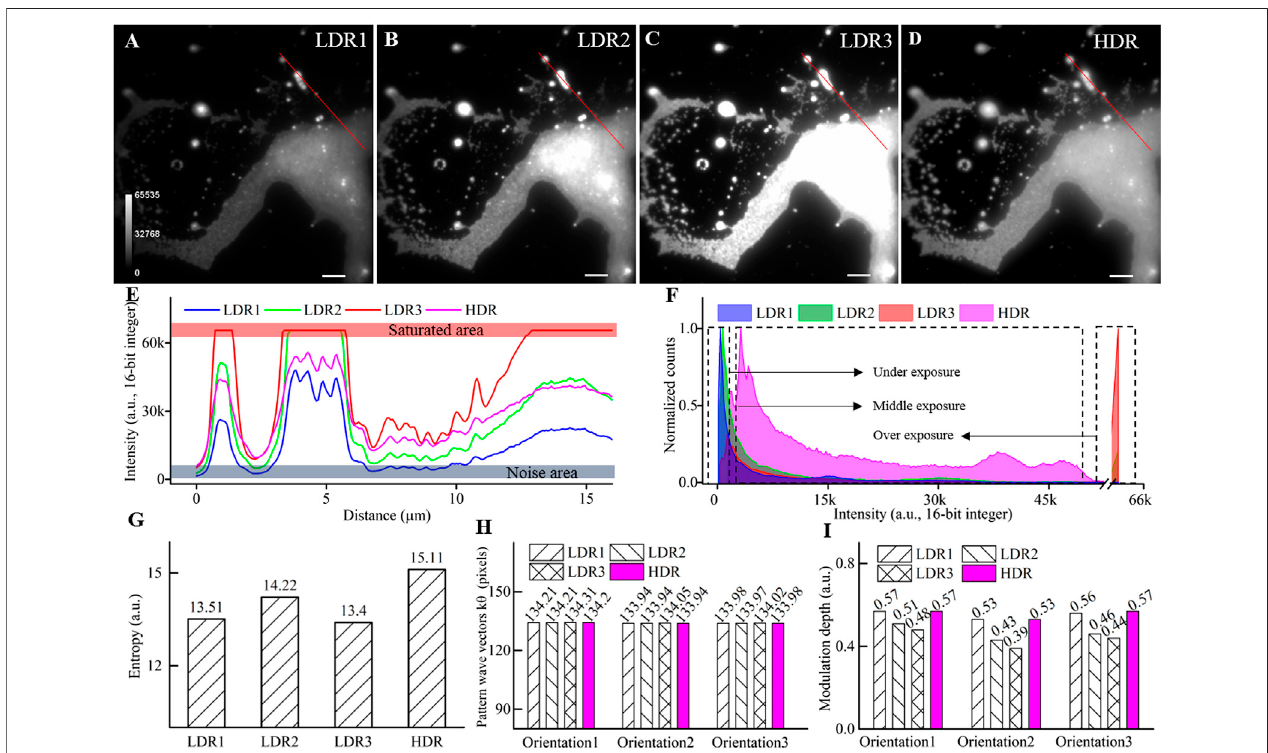
FIGURE 2 | Performance of the HDR fusing to widen the dynamic range. (A – C) LDR images of clustered fl uorescent beads acquired with different excitation intensitiescorrespondingtounder,middle,andoverexposure. (D) HDRimagebyfusingtheabovethreeLDRimages. (E) Intensitypro fi lesalongtheredlinesin (A – D) . (F) The normalized histogram. (G) The entropy of the LDR and the HDR image. (H) Period of illumination pattern wave vector ( k ) at three orientations. (I) The modulation depth of illumination pattern at three orientations. Scale bar: 3 μ m for (A – D) .